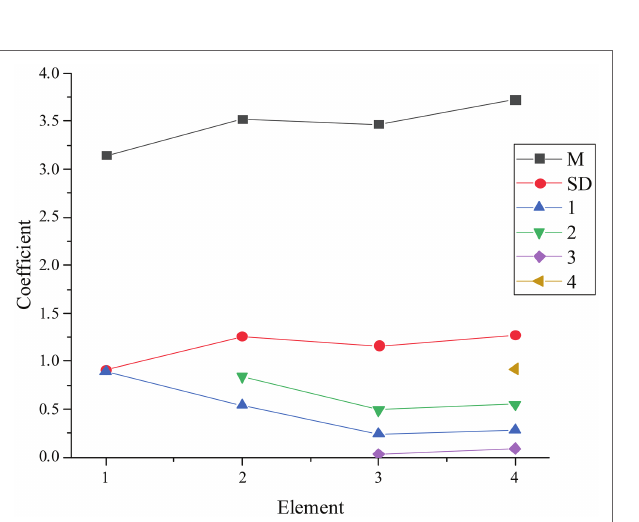
FIGURE 6 | Test results of hypotheses a1 to a5 ( M is the average value, SD is the standard deviation, 5 is the performance orientation, 6 is the maintenance orientation, 7 is the type of the first quadrant, 8 is the type of the second quadrant, 9 is the type of the third quadrant, 10 is the type of the fourth quadrant, 11 is organizational psychological ownership, and 12 is employees’